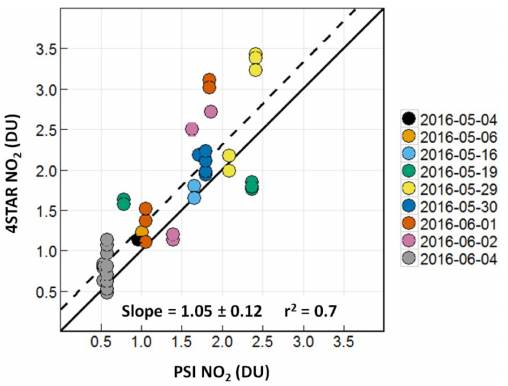
Figure 11. A correlation plot of C ( NO 2 ) from 4STAR onboard the DC-8 compared to the C ( NO 2 ) amount measured by the PSI at Olympic Park on nine different days. The solid black line is the 1:1 line drawn for reference. The dashed line represents the data linear fit, with a slope of 1.05, and a correlation coefficient r 2 = 0 . 7, as shown on the